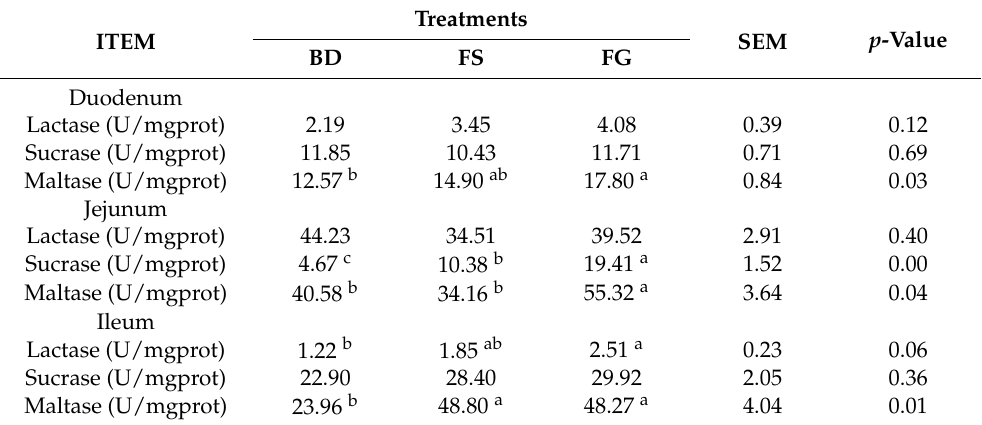
Table 5. Effect of different iron sources on mucosal enzyme activity in weaned